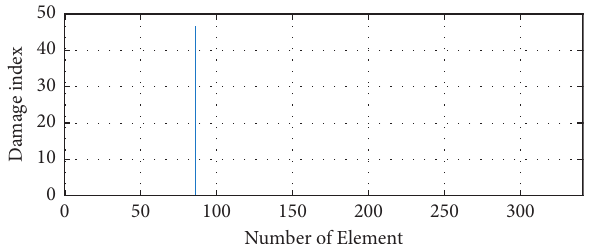
Figure 8: Results of D2 using MCA-DI (L-shape building).